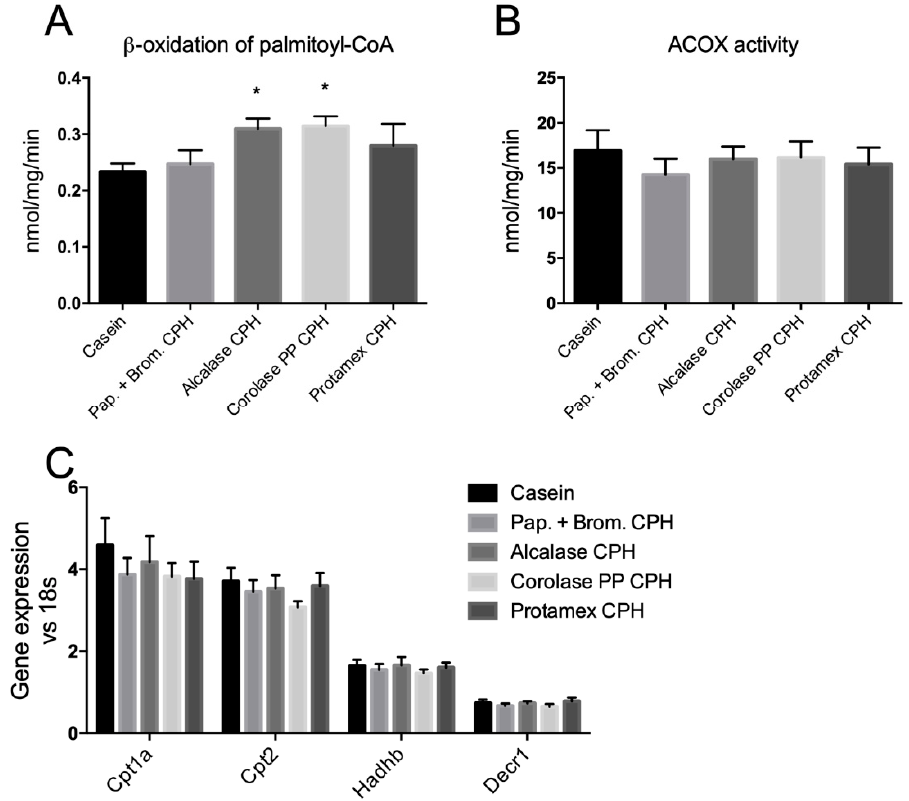
Figure 5. Hepatic β -oxidation in C57BL/6 mice fed high fat/high sucrose diets with casein (19 E%) or casein (9.5 E%) combined with different CPHs (9.5 E%) for 12 weeks. ( A ) In vitro β -oxidation of palmitoyl-CoA in fresh liver homogenates. ( B ) In vitro activity of acyl-CoA oxidase 1 (ACOX1) in frozen liver homogenates. Mean values with standard deviation are shown ( n = 5–6). ( C ) Hepatic gene expression of carnitine palmitoyl transferase 1a ( Cpt1a ), Cpt2 , hydroxyacyl-CoA dehydrogenase trifunctional multienzyme complex subunit beta ( Hadhb ), and 2,4-dienoyl-CoA reductase 1 ( Decr1 ). Mean values with standard deviation are shown ( n = 7). Significant differences between values were determined by one-way ANOVA with Fisher’s LSD test (* p < 0.05).